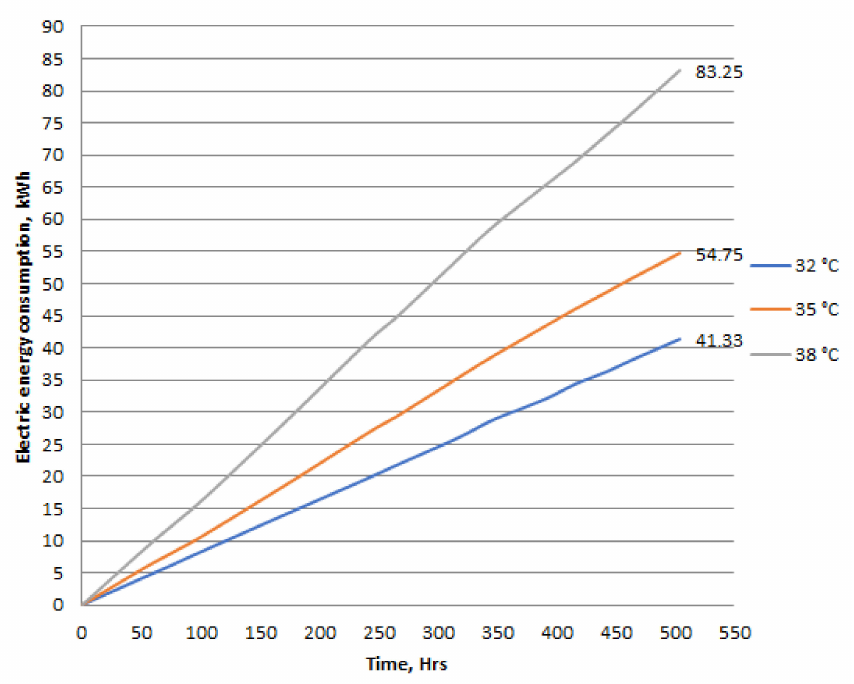
Figure 14. The average electric energy consumed at each temperature’s level.